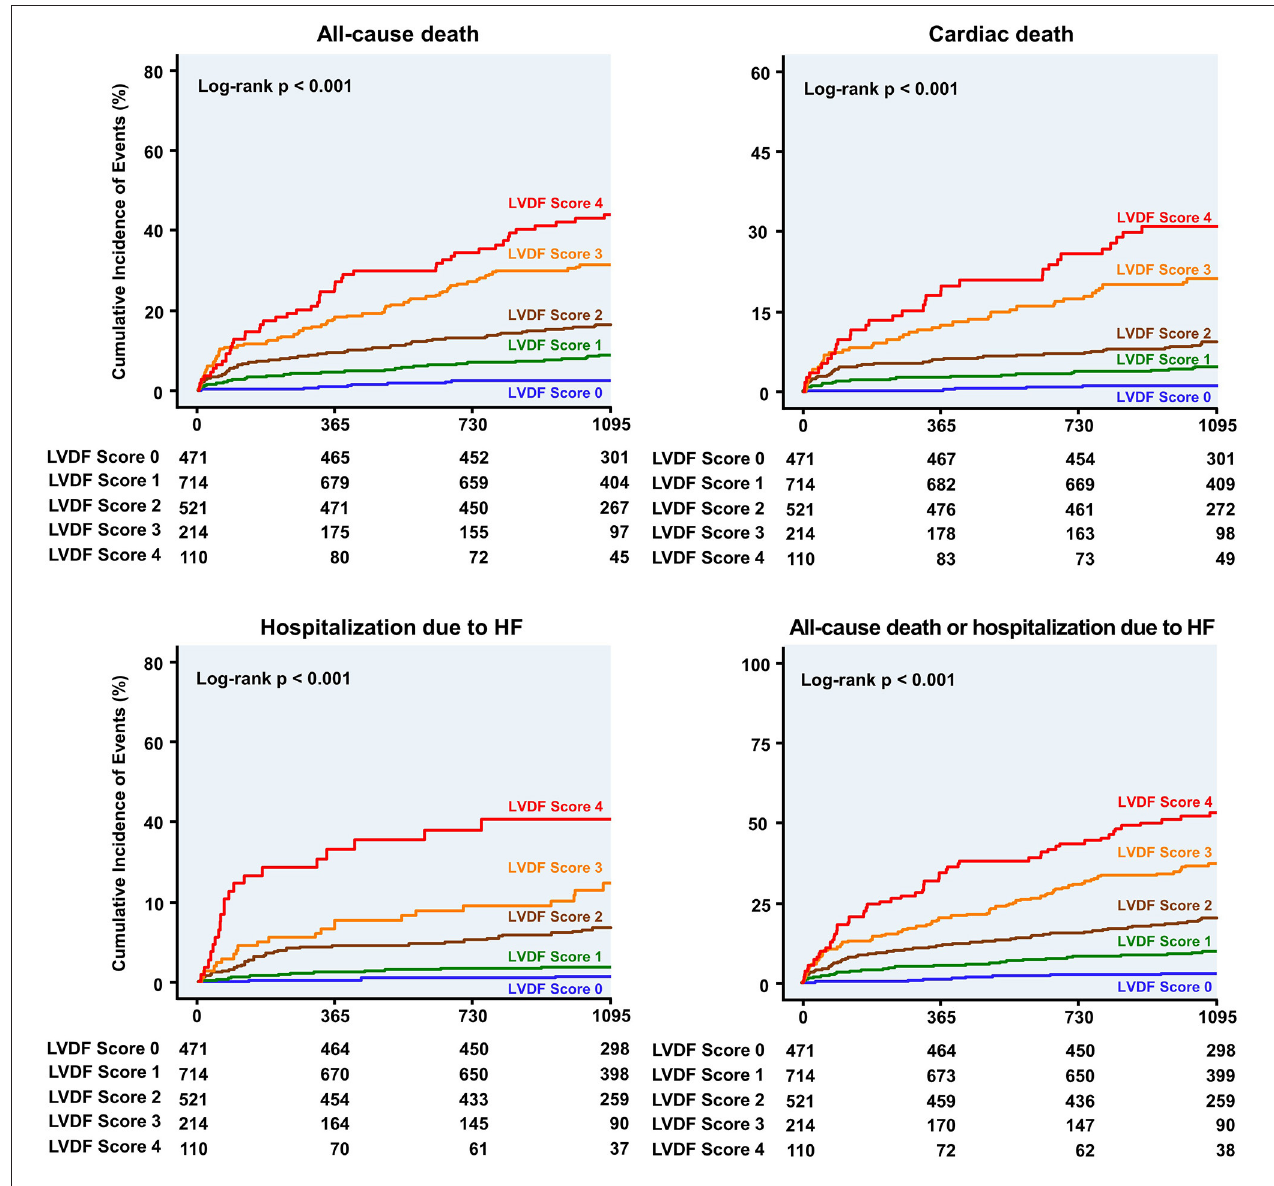
FIGURE 3 | Kaplan–Meier curves for clinical outcome according to the LVDF score. Patients with higher LVDF scores had a higher rate of all-cause mortality, cardiac death, or hospitalization due to HF than patients with lower LVDF scores (log-rank p < 0.001). HF, heart failure; HR, hazard ratio; LVDF, left ventricular diastolic